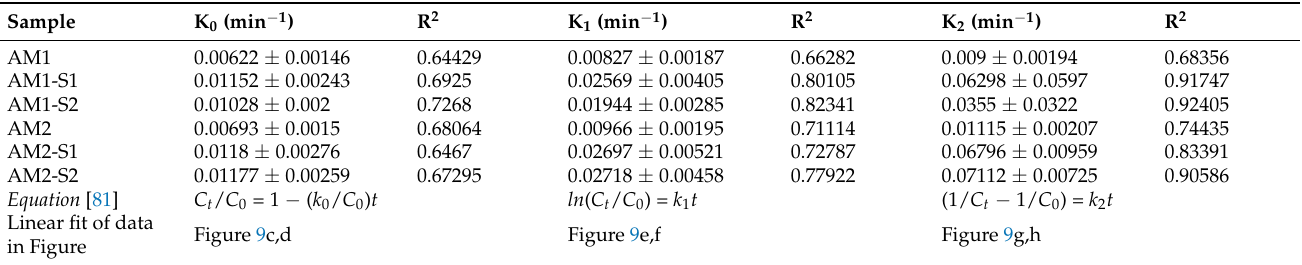
By comparison with the Fe 3 O 4 @ZnO [62] and Fe 3 O 4 @Ag@TiO2 [80] nanocatalysts